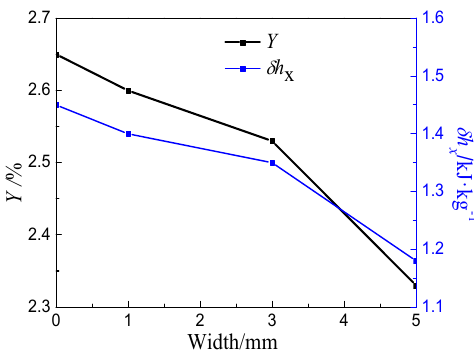
Figure 11. Dehumidification performance of cascade.